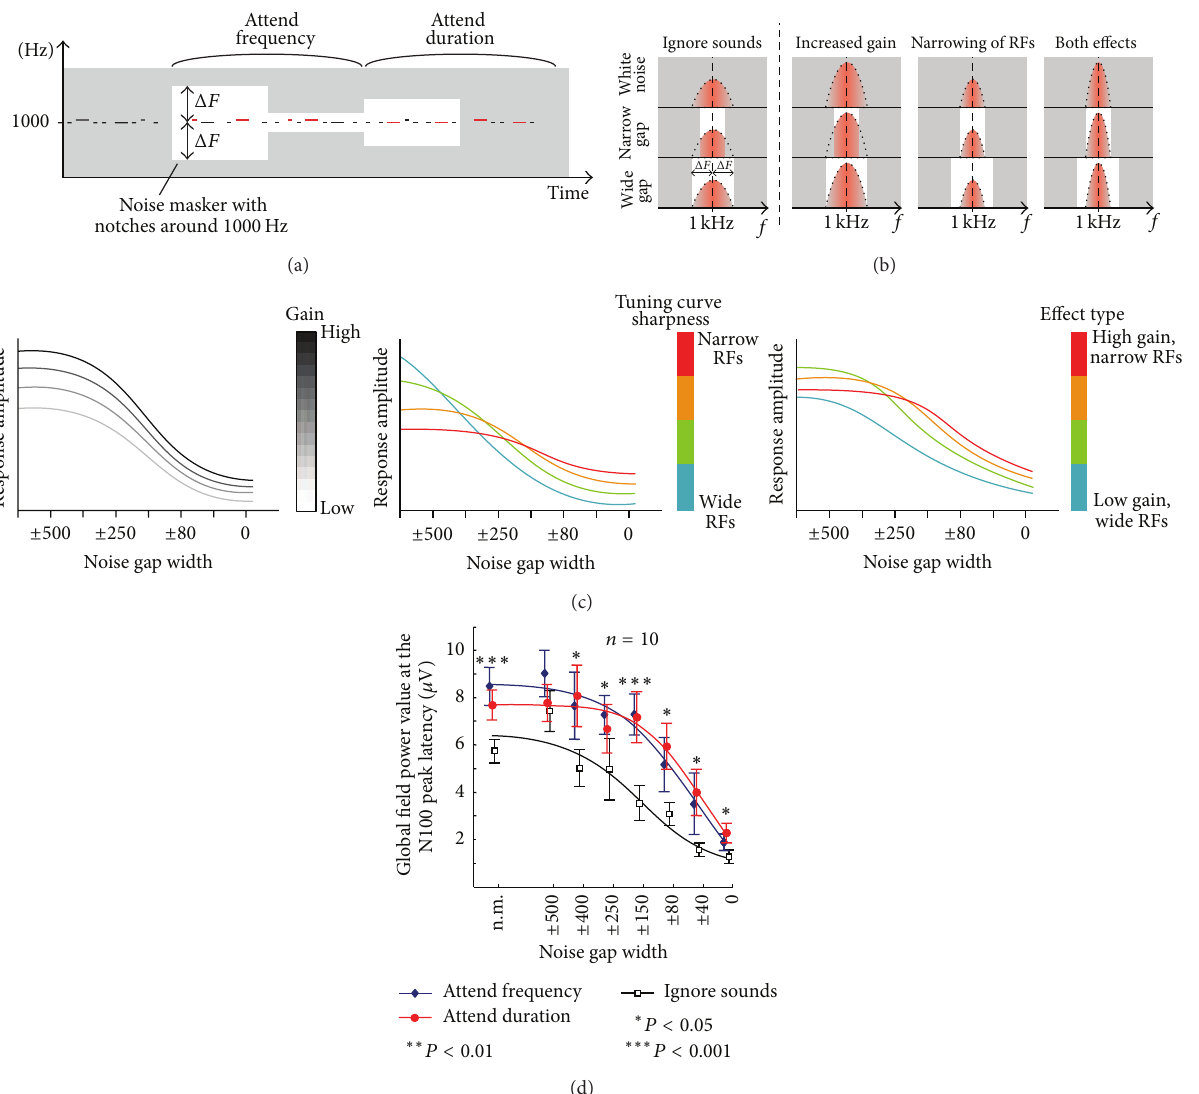
Figure 2: Selective attention increases both the gain and selectivity of auditory-cortex neural populations. (a) Target tones (red color) were either higher in frequency or longer in duration. Background gray represents the noise masker and the white area represents notch in the noise.(b)Bell-shapedcurvesrepresentthepresumedsingle-neuronreceptivefields(RFs)duringbaseline(Ignore)andtheproposedattention- dependent changes in the RFs (increased gain versus narrowing of RFs versus both effects). It is assumed that noise suppresses responsiveness of the neuron to the 1kHz tone as a function of its overlap with the receptive field of auditory-cortical neuron, with the red-colored area below the bell-shaped curve indicating how likely the neuron is to respond to the 1 kHz probe sound. In the white-noise condition, it is assumed that only neurons optimally tuned to the tone respond. (c) Simulated effects at the level of neuronal population responses as a function of notch width. Note that with the “gain only” mechanism, the amplitude-reduction function remains identical between the stimuli endpoints and is only scaled differentially, while the other mechanisms result in modulation of the basic shape of the amplitude reduction function. (d) Amplitudes at N1 response peak latency showed nonmultiplicative suppression with narrowing of the notch in the noise masker during selective-attention. Comparison with the three alternative models suggested that both increased gain and enhanced selectivity take place during auditory selective-attention. Adapted with permission from